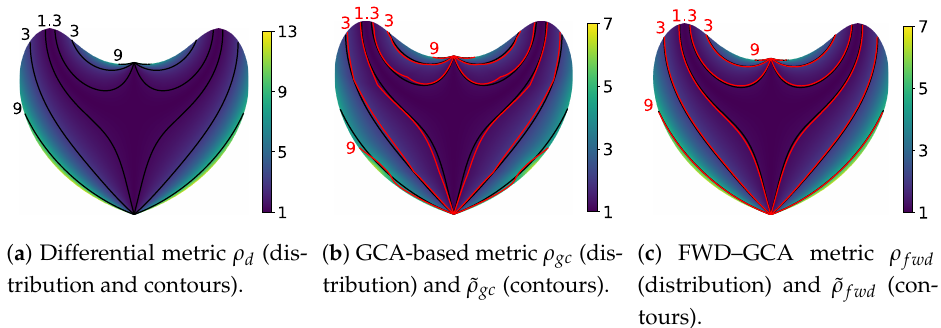
Figure 5. Distribution and contours of the differential-based, GCA-based, and FWD–GCA metrics for the Bonne